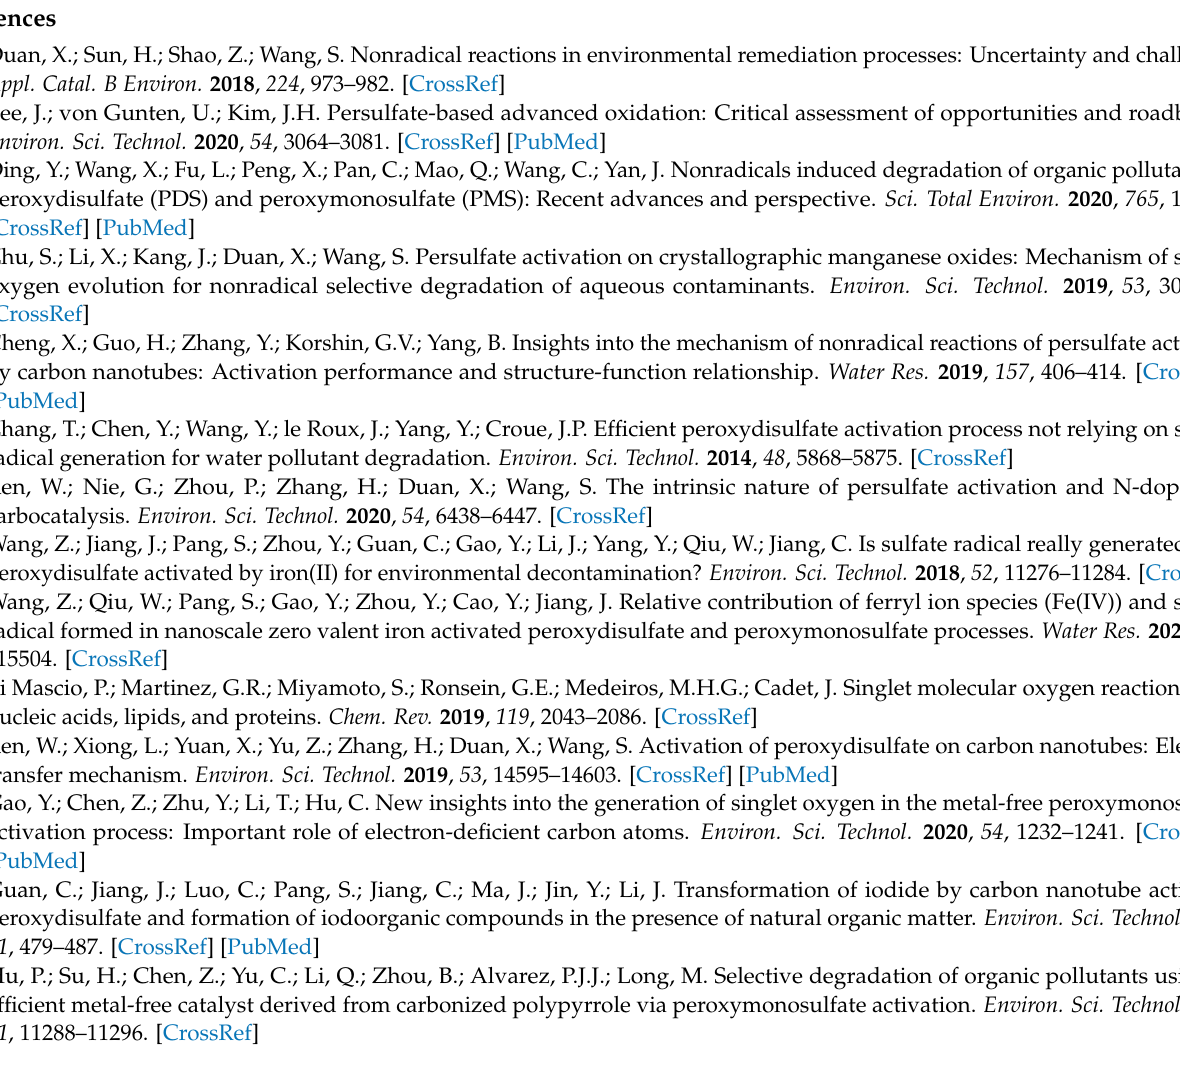
on SMX; Figure S16: LC-MS chromatograms of SMX and the transition products; Figure S17: Numbers of the atoms in SMX; Table S1: Reaction rate constants of the chemical quenchers and ROS [4,90]; Tables S2–S4: Pseudo-first order parameters of SMX degradation influenced by dosages of SMX, catalyst, and PDS; Table S5: Parameters of tap water and surface water; Table S6: Fukui